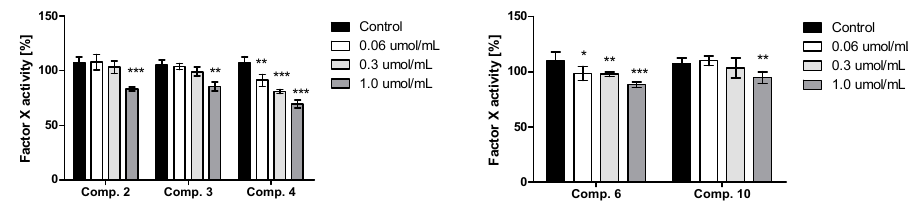
Figure 6. Effects of selected compounds ( 2 , 3 , 4 , 6 and 10 ) on the activity of factor X (data are presented as mean ± SD; n = 4–5) after 1-min incubation with plasma deficient factor X; final volume 210 µL. The asterisk denotes a statistically significant difference between the samples treated with compounds and respective controls; * p < 0.05, ** p < 0.01, *** p < 0.001. All tested compounds at the highest concentration decreased the activity of factor X.